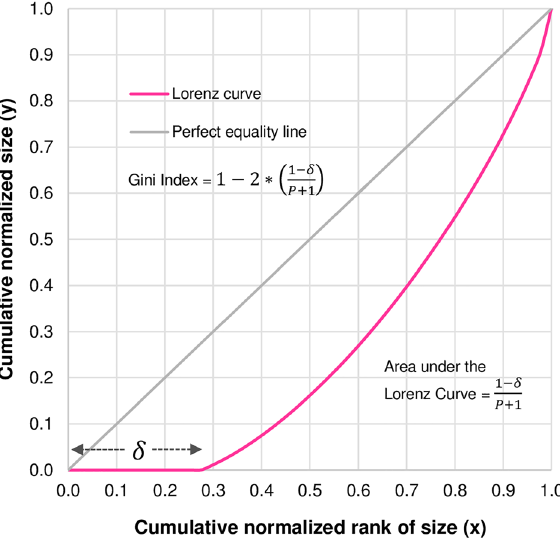
Figure 1. The Lorenz curve and the closed-form expression for the Gini